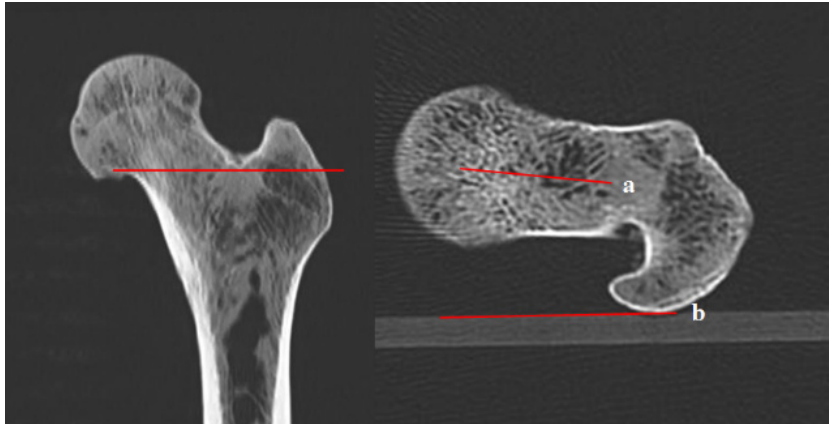
Figure 5. Left image: The femoral anteversion angle (angle between a and b) is calculated using the A line on the mid-femoral neck transverse section of a single transverse sectional image of the femoral neck just below the femoral neck (left image). Right image: (a) The connecting line between the center of the partially visible head and the center of the neck on the transverse section; (b) the connecting line of the posterior border of both femoral